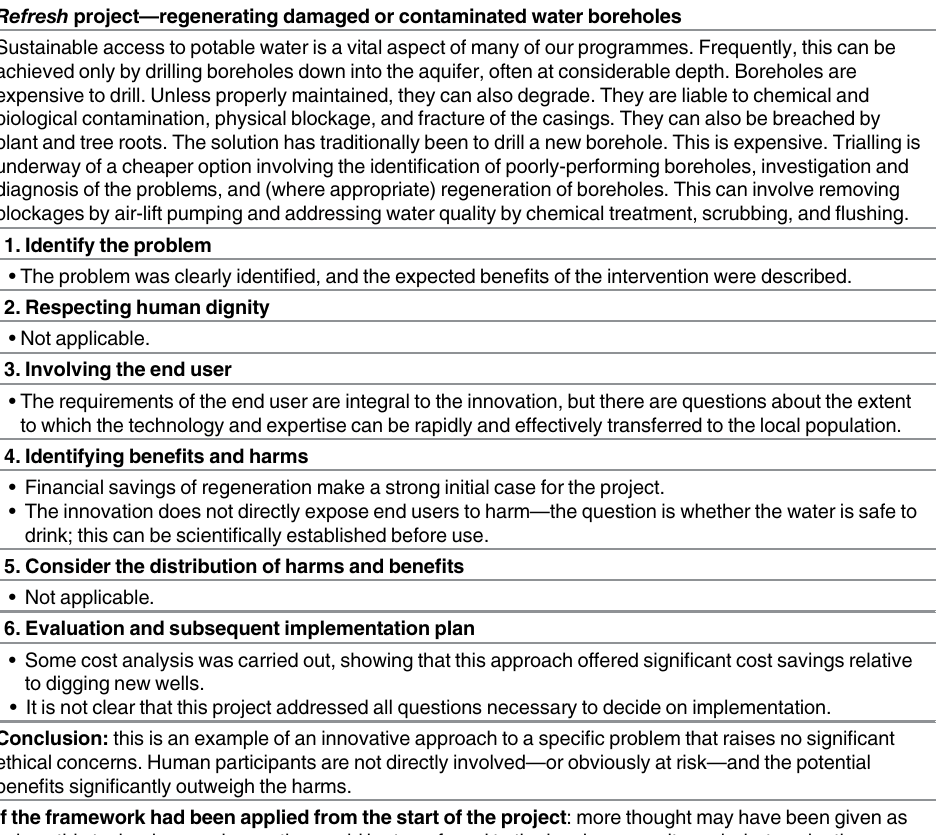
Table 2. The Niger REFRESH borehole project: a paradigm change